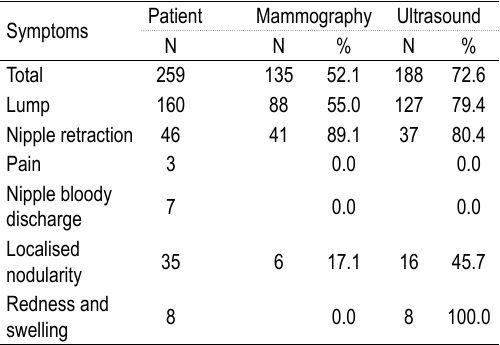
Table 8. Comparative specificity of mammography and ul - trasound according to